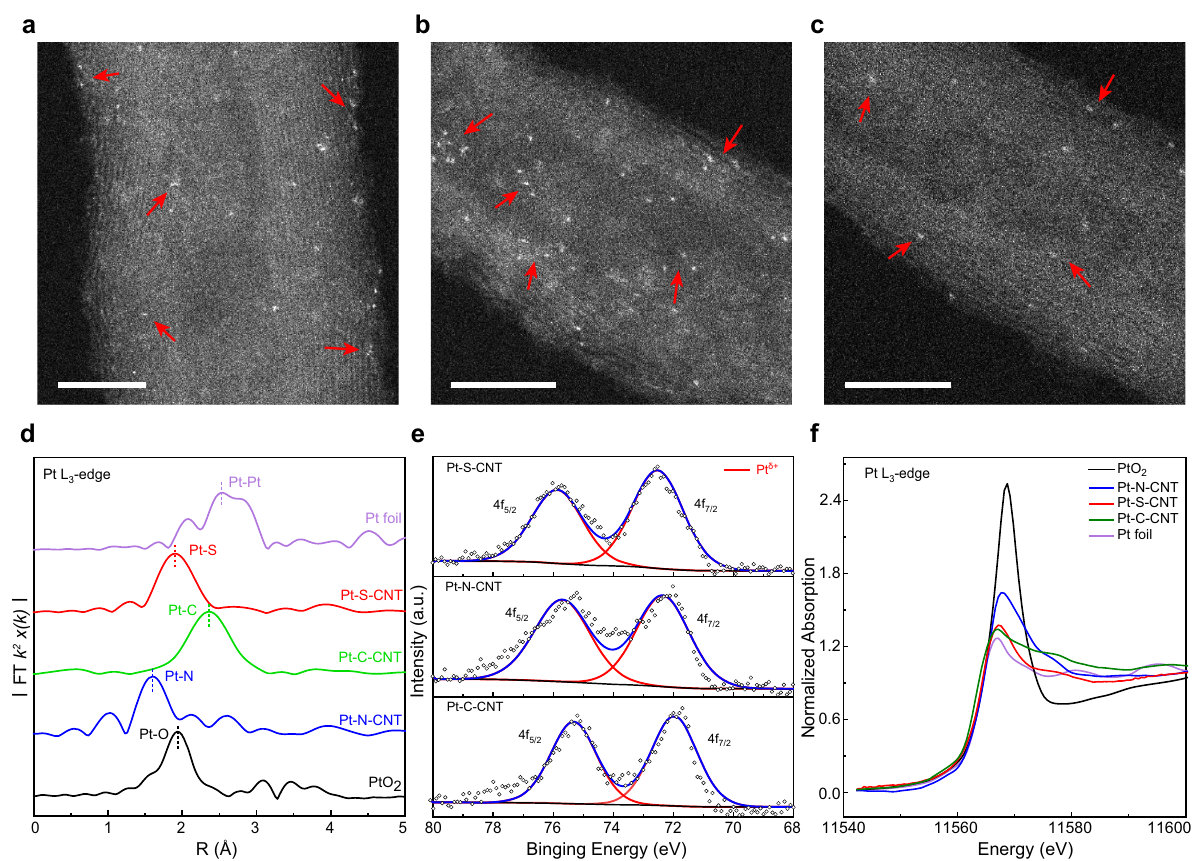
Fig. 1 Characterizations of Pt-X-CNT catalysts. HAADF-STEM images of a Pt-S-CNT, b Pt-N-CNT, and c Pt-C-CNT, the bright dots (as marked by red arrows) represent typical Pt single atoms. Scale bars, 5 nm. d k 2 -weighed Pt L 3 -edge FT-EXAFS spectra for as-prepared Pt-X-CNT in the R space, e core- level XPS spectra for Pt 4 f region, and f corresponding XANES spectra at Pt L 3 -edge in comparison to Pt foil and PtO 2